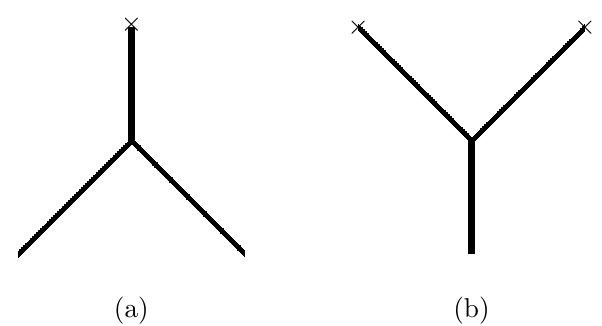
Figure 1 . The Feynman diagrams contributing to the imaginary parts of f ( ω 1 , ω 2 ) (figure (a)) and g ( ω ) (figure (b)). The thick lines denote closed string propagators and the × ’s denote the closed string one point function on the